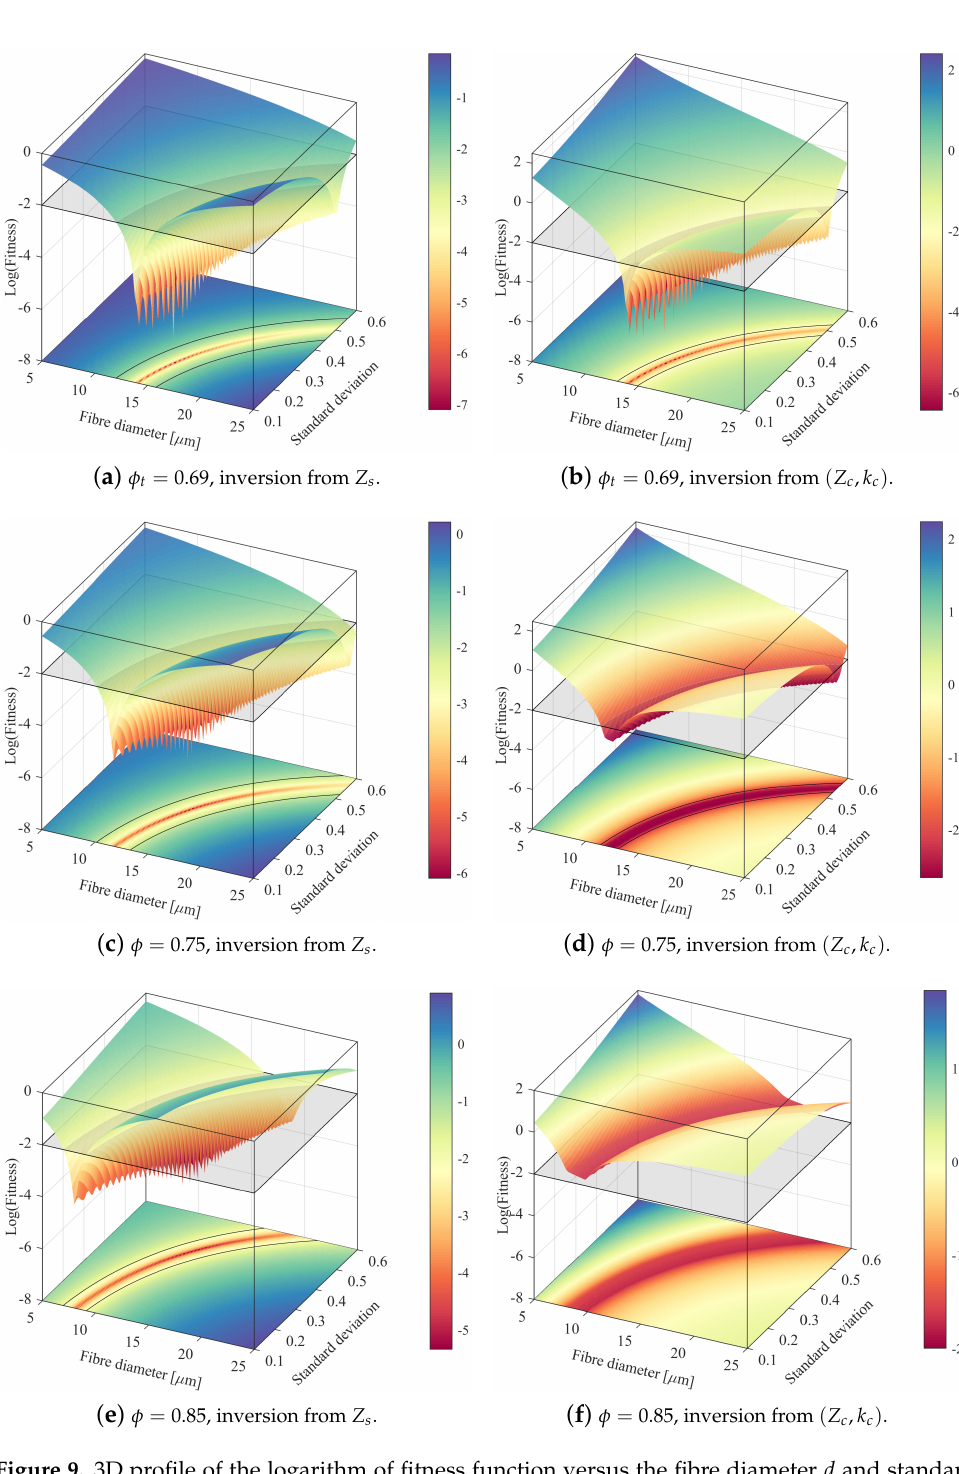
Figure 9. 3D profile of the logarithm of fitness function versus the fibre diameter d and standard deviation σ s with the fixed porosity φ , and 2D projection along d − σ s plane with contour plot at Log ( Fitness ) = − 2. ( a , c , e ) Varying different porosity to investigate inverse characterisation from the surface impedance Z s . ( b , d , f ) Varying different porosity to investigate inverse characterisation from two porous material properties [ Z c , k c ]